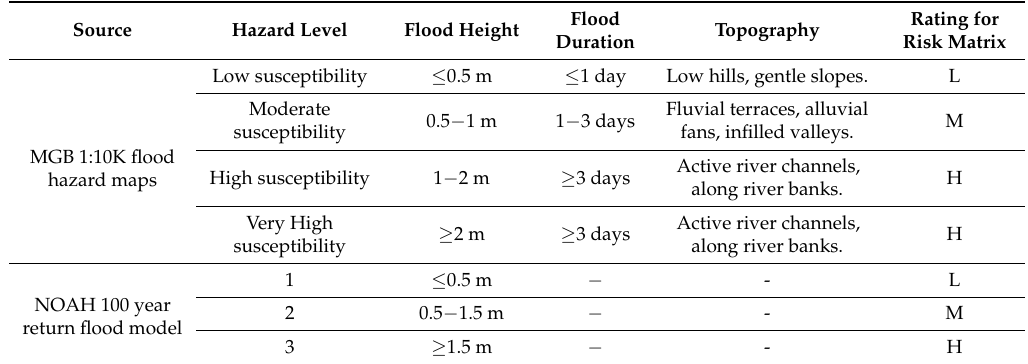
Table 1. Flood hazard levels derived from Mines and Geosciences Bureau (MGB) and Project NOAH maps. The rating for risk matrix column on the right hand side attempts to merge these hazard levels into simple high (H), medium (M), and low (L) scores so they can be combined within the risk matrix (Figure